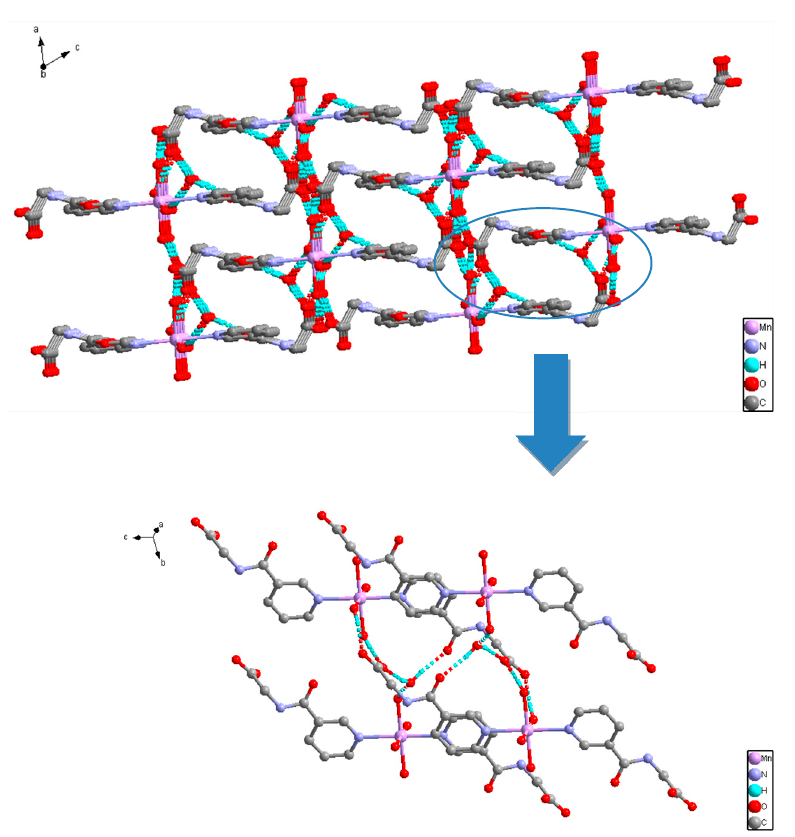
Figure 4. The 3D supramolecular net structure of 1 . Table 1. Selected bond lengths (Å) and angles (°) for 1 .